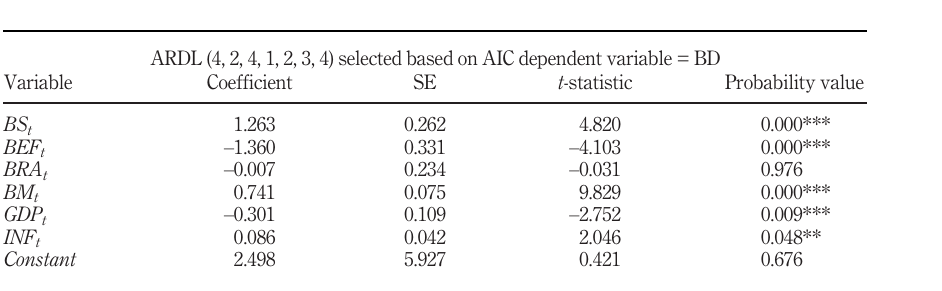
Table 5. Long-run